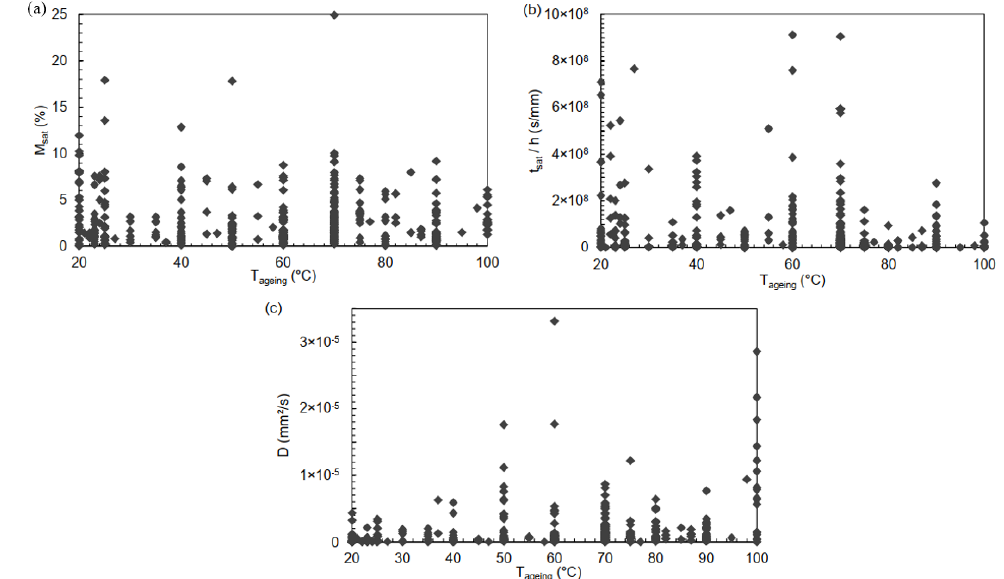
Figure 5. Evolution of ( a ) M sat , ( b ) t sat / h et ( c ) D as a function of the ageing temperature T ageing